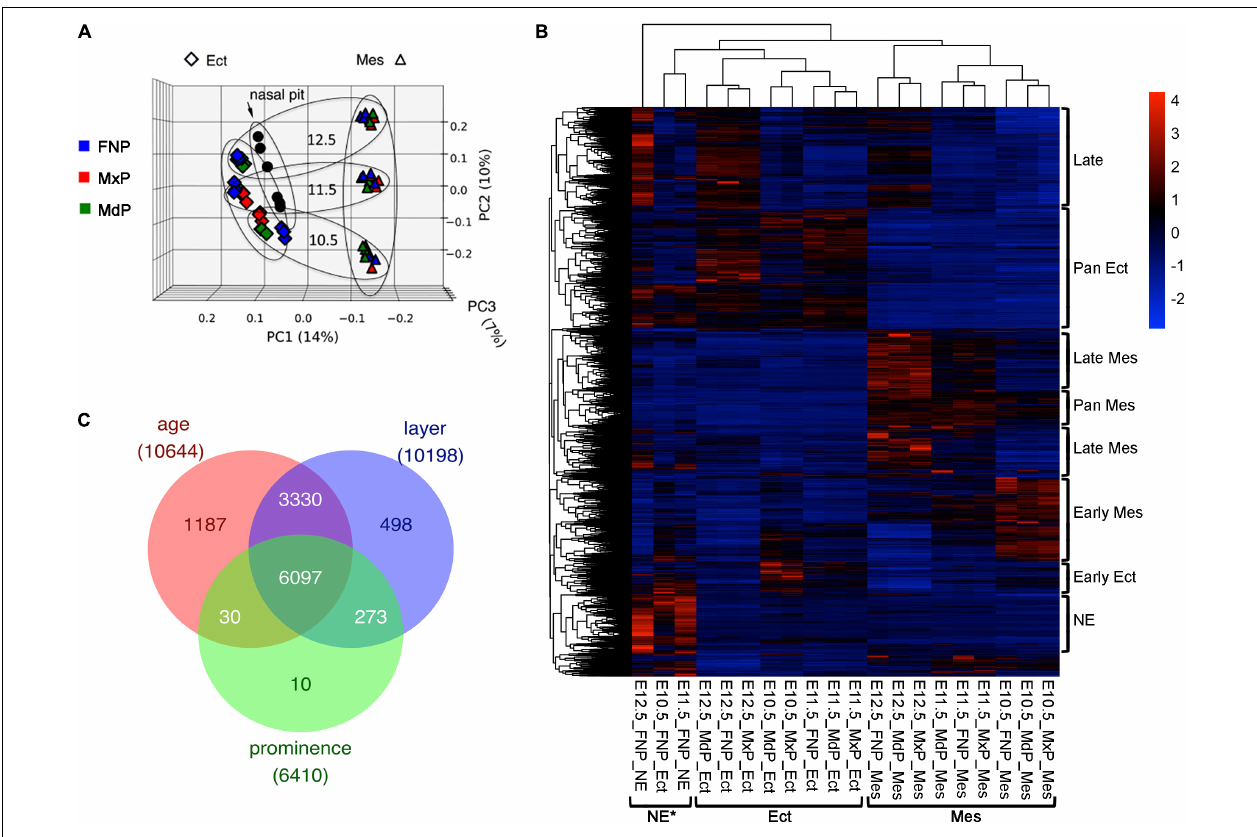
FIGURE 1 | RNA-seq for the developing mouse face. (A) Principal component analysis of the RNA-seq data of 60 facial samples: ectoderm (rhombus), mesenchyme (triangle), nasal pit (circle), FNP (blue), MxP (red), and MdP (green). These samples separated first by tissue layers (PC1) and then by age (PC2). Note, PC3 does not separate by prominence. Larger ovals group the sample ages (more horizontal), or layers (more vertical). (B) Gene expression program for facial development. Heatmap of ∼ 11,000 differentially expressed genes (maximal average FPKM across all samples > 1, minimal adjusted p -value across all samples < 0.01, and maximal fold change across all samples > 2) after scaling with color key at upper right. Each row is a gene, and each column is a sample with mean expression from three biological replicates. The sample names are shown at the bottom. The samples are clustered mainly by tissue layers as bracketed at the bottom. The differential expressed gene programs are bracketed on the right side of the heatmap. GO terms enriched in these gene programs are shown in Supplementary Table 3 . (C) Venn diagram showing differentially expressed genes by age, layer, and prominence. The number of shared or unique genes are labeled in the corresponding area. Ect, ectoderm; FNP, frontonasal process; MdP, mandibular prominence; Mes, mesenchyme; MxP, maxillary prominence; NE, nasal epithelium. *Note that the E10.5_FNP_Ect is a mixture of NE and FNP surface